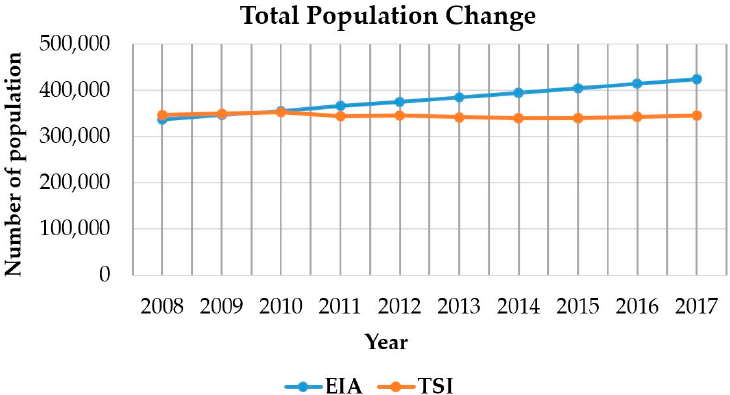
Figure 9. Total population change for the four districts from 2008 to 2017, according to different sources.